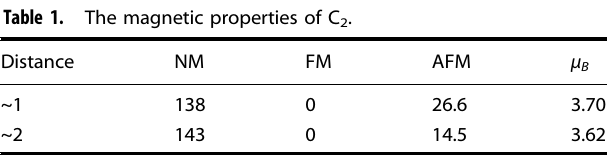
Blister-to-blister distance (nm), total energy difference (meV) for different magnetic con fi gurations, and magnetic moment ( μ B ) for long-range magnetic interaction in the C 2 Blister